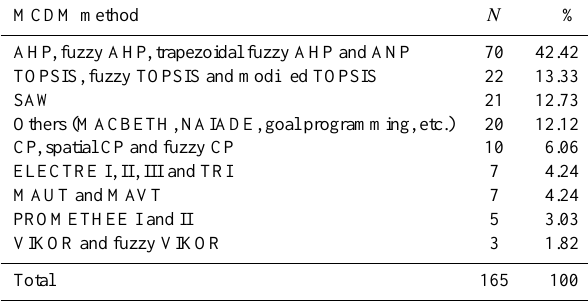
Table 4. Distribution of applications by MCDM